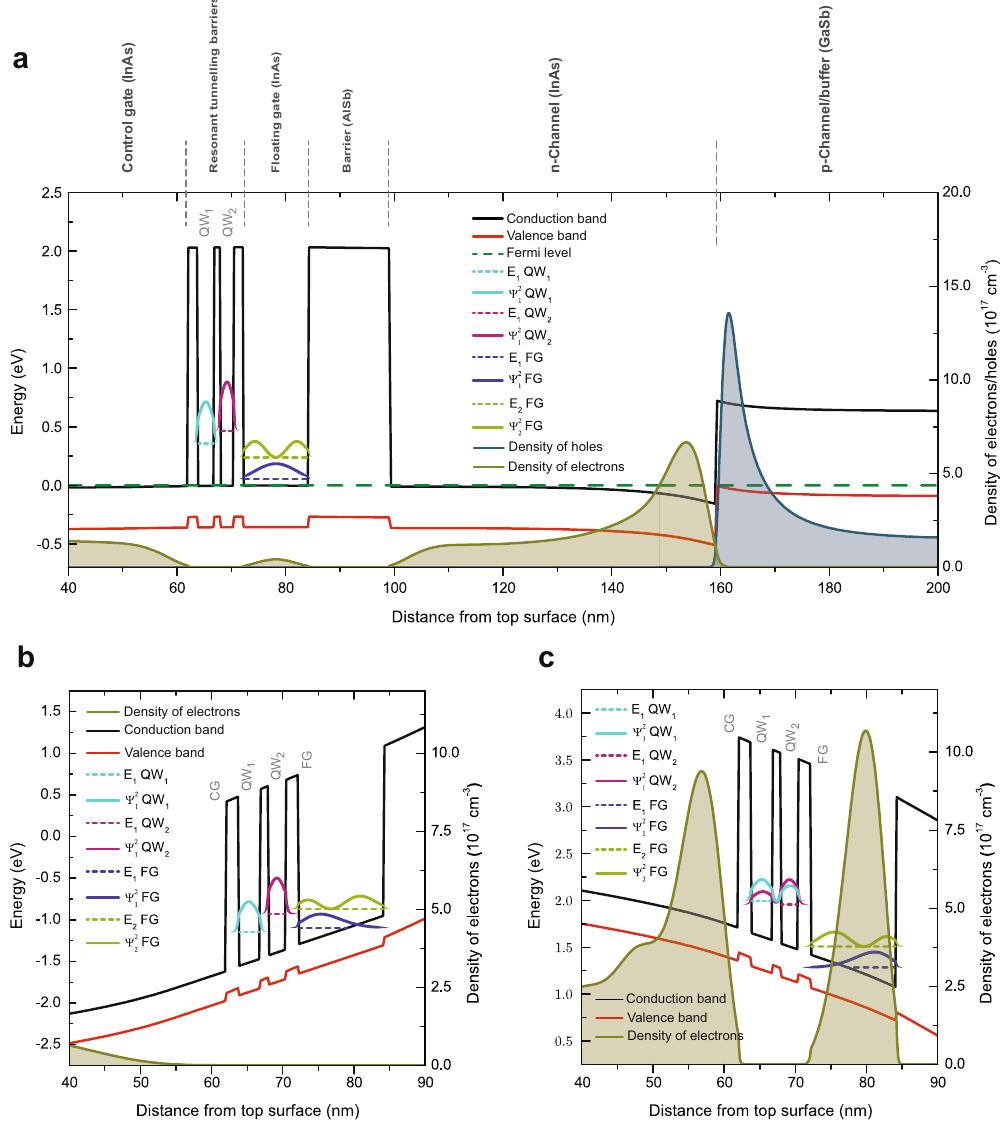
Figure 2. Calculated band diagram vertically through the structure. The black and red lines represent the bottom of the conduction band and the top of the valence band respectively, whilst the green long-dashed line is the Fermi-level. Short-dashed lines represent energies of the lowest confined states in the quantum wells (QWs) of the resonant-tunnelling structure, and the ground and the first excited-states in the floating gate (FG). The probability densities, Ψ 2 , for the position of the electrons in the QWs and the FG are plotted in arbitrary units. The densities of electrons and holes are plotted as olive and blue shaded areas respectively. ( a ) In the absence of SE = + 2.6 V, showing the depletion of the FG bias across the device. ( b ) At the end of the erase process with − V CG SW = − 2.6 V. This results in a significant density of of electrons. ( c ) At the end of the write process when − V CG electrons in the